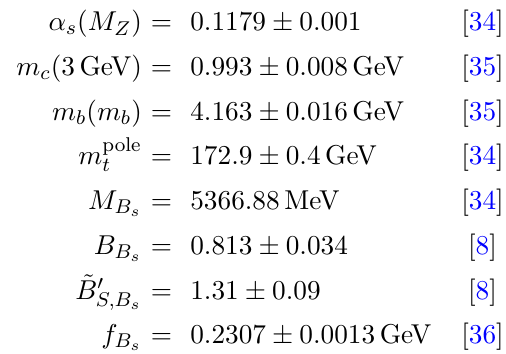
[36] corresponds to m ( m ) = (163 . 1 ± 0 . 4) GeV in t t t = B ( µ ) and ˜ B 0 = ˜ B 0 ( µ ) with µ = m pole = B s B s 2 2 2 S,B s S,B s b